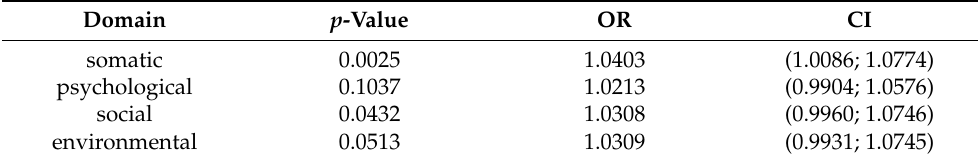
Table 8. The association between physical activity and score domains after